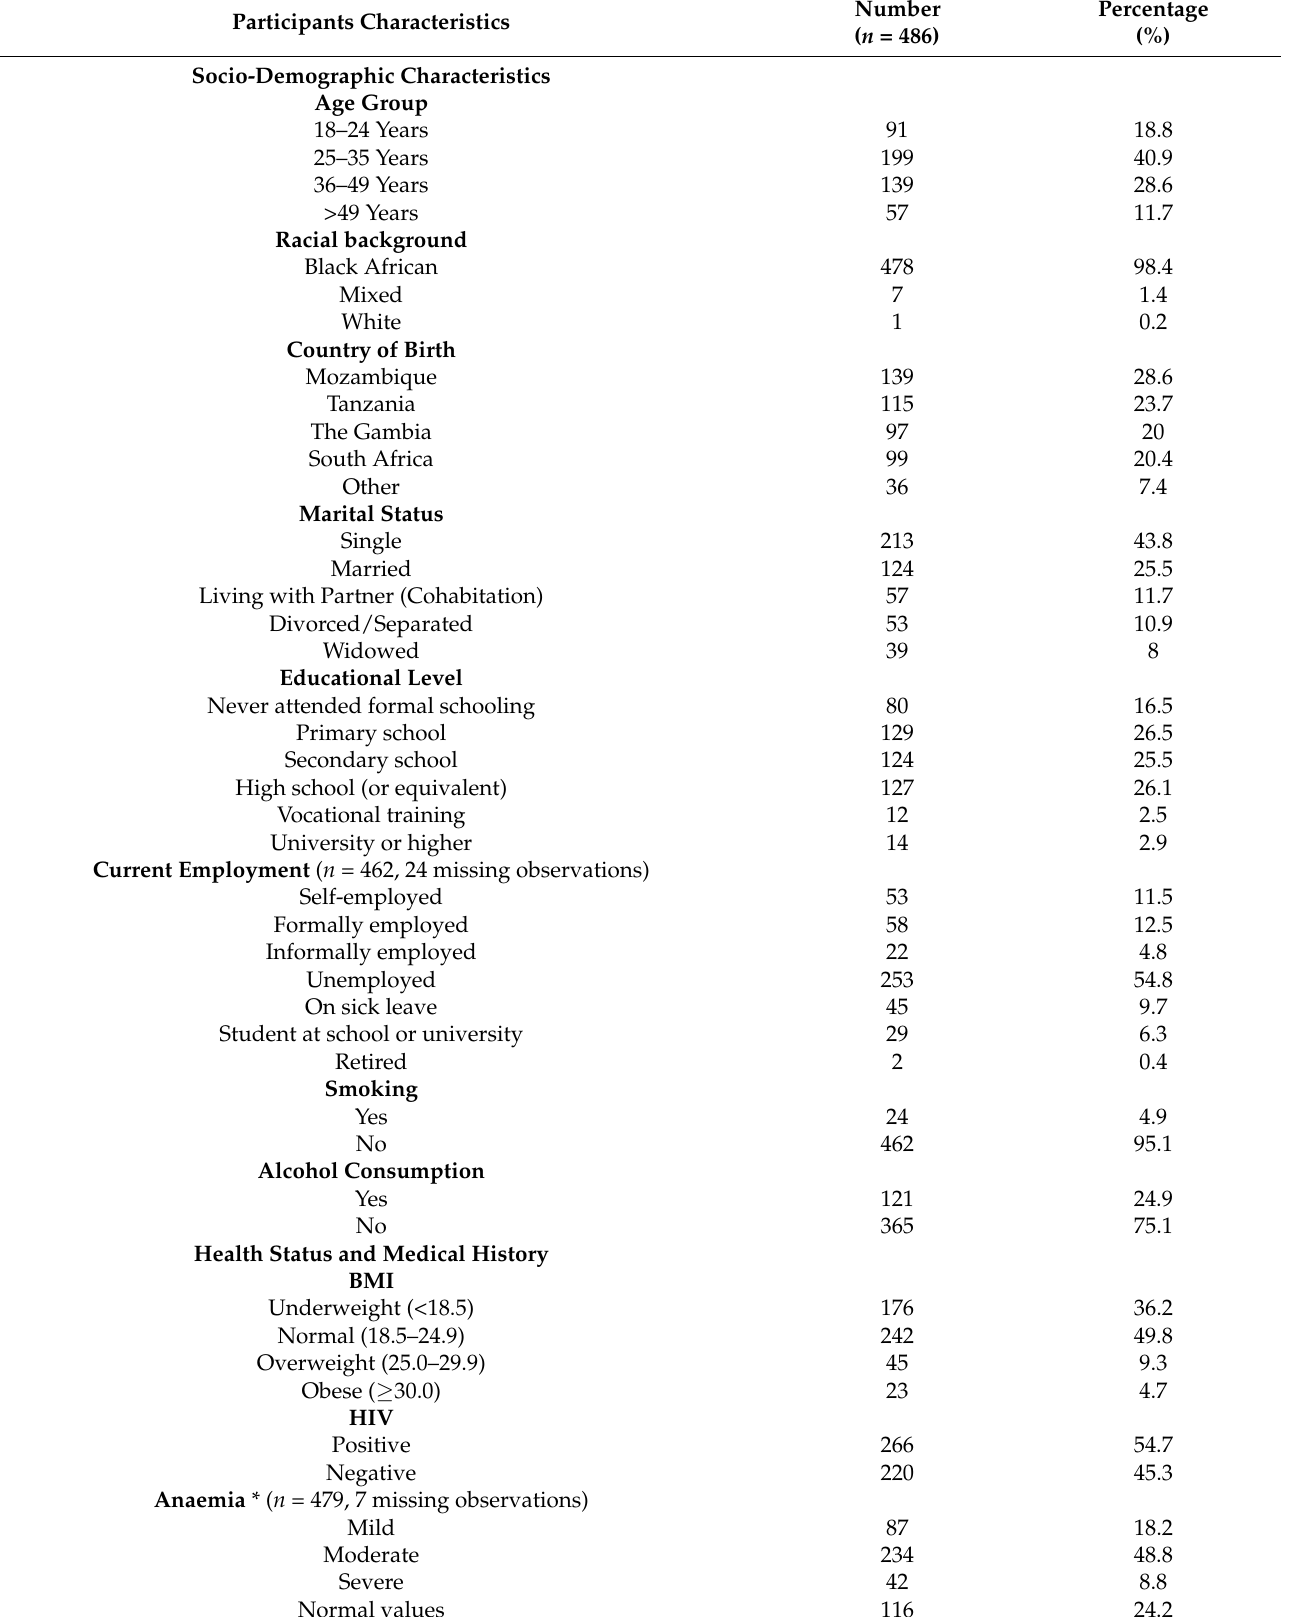
Table 1. Socio-demographic characteristics, health status and medical history of the participants. Participants